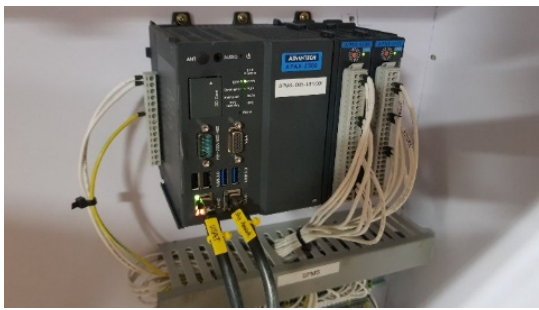
Figure 2. Data collection system in Voyage Data Recorder (VDR).